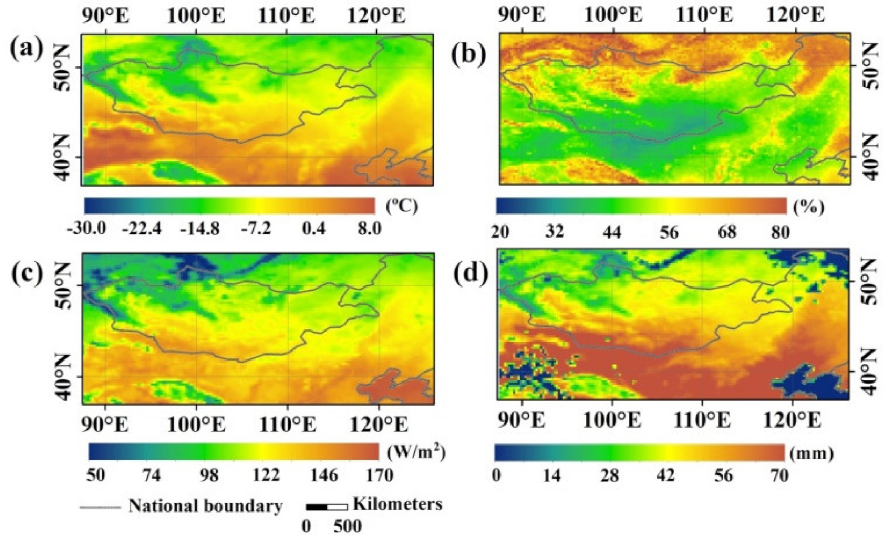
Figure 5. Spatial distribution of key monthly mean energy cycle parameters over the MP and surrounding areas in January–April of 2016–2020. ( a ) Monthly mean surface temperature. ( b ) Monthly mean Himawari 8 total cloud cover. ( c ) Monthly mean surface net shortwave radiation. ( d ) Monthly mean potential